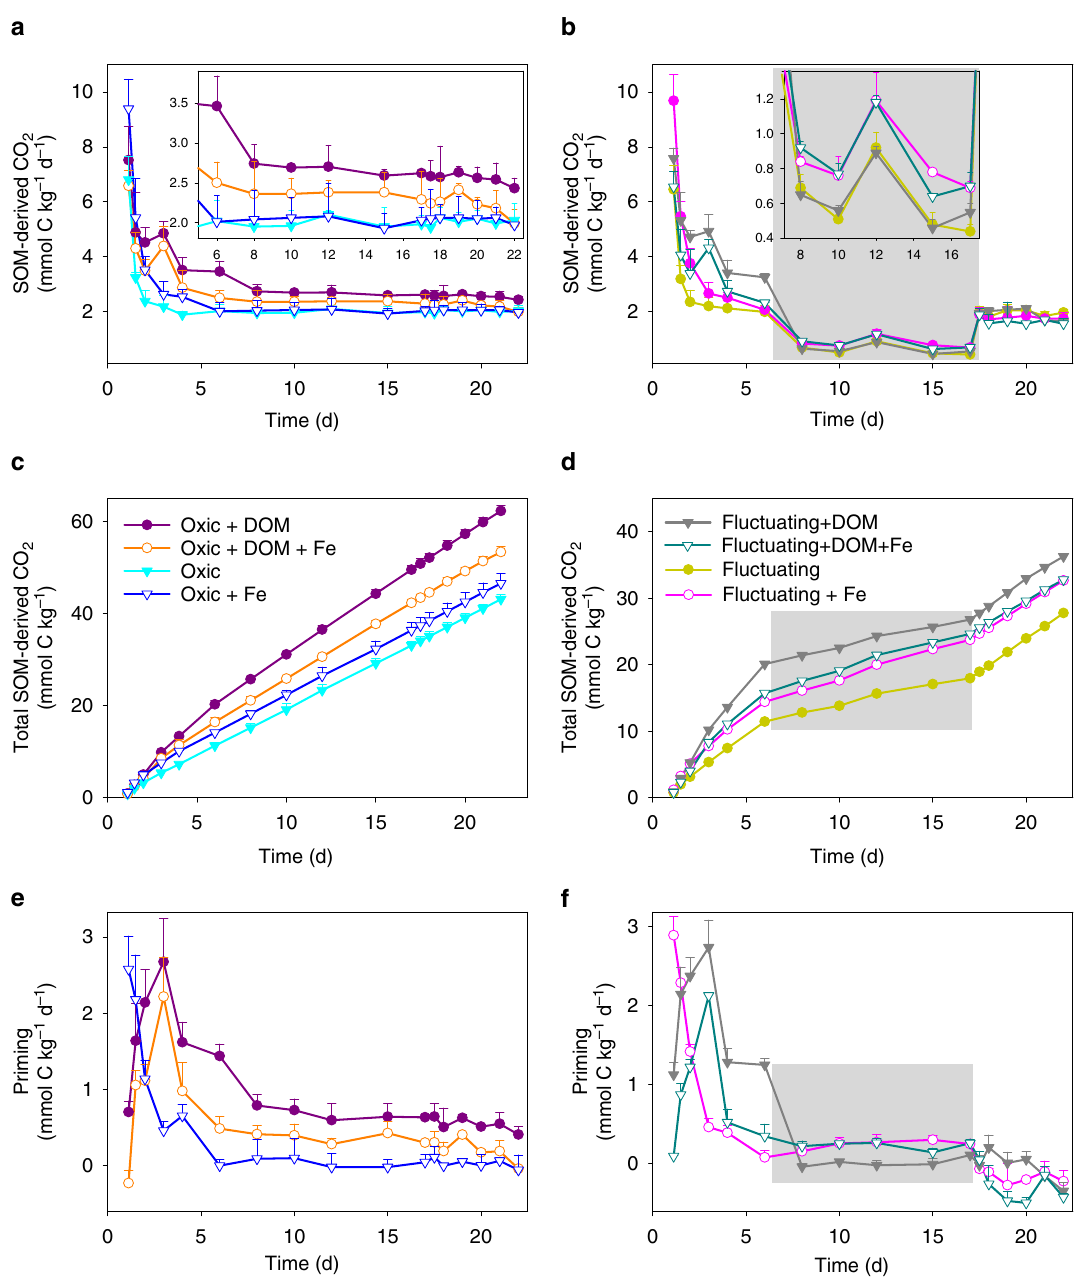
Fig. 6 Native soil C mineralization. CO 2 production rates from soil C under a static-oxic and b redox- fl uctuating conditions, cumulative CO 2 production from soil C under c static-oxic and d redox- fl uctuating conditions, and priming of soil C under e static-oxic and f redox- fl uctuating conditions. The gray shaded region represents the anoxic phase of the redox- fl uctuating treatment. Error bars indicate s.e.m. ( n =